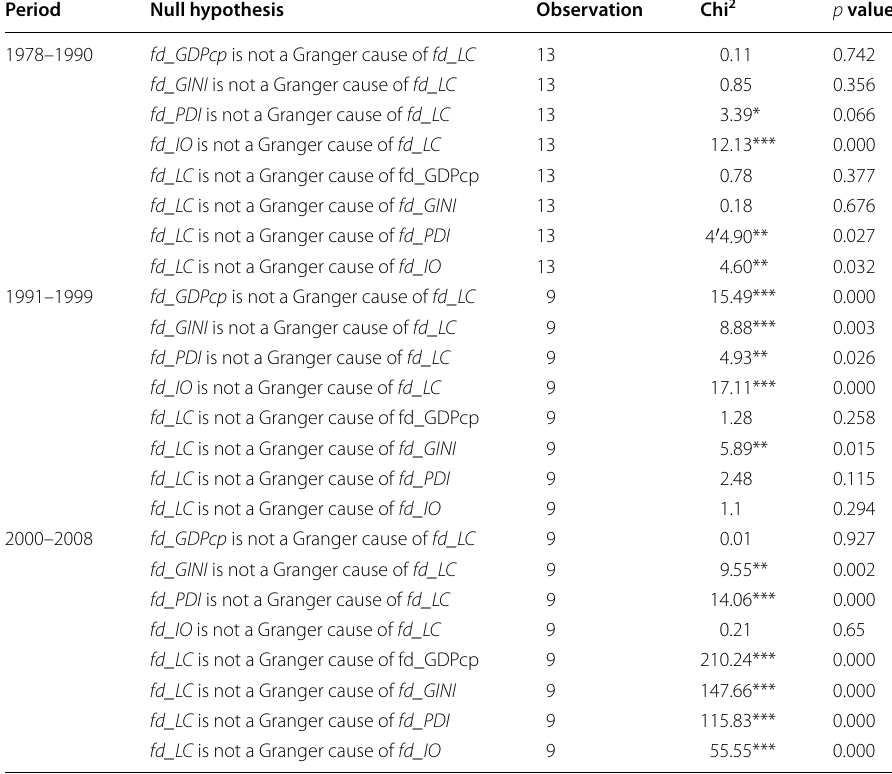
Table 4 Granger test of stratum attention and macro-level economic and political factors in different stages of the reform Period Null hypothesis